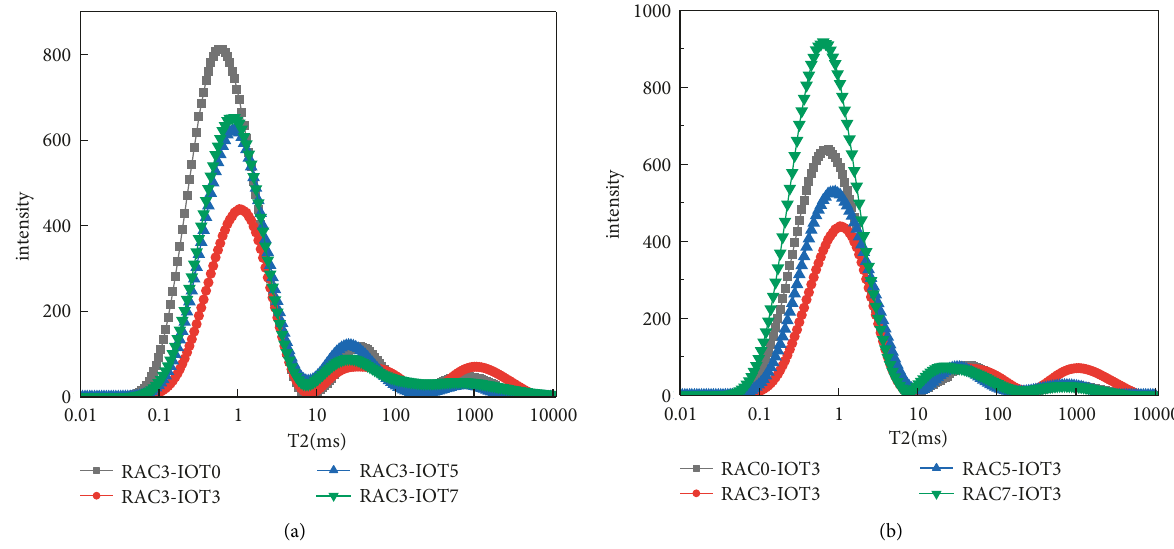
Figure 12: T2 Atlas before F-Tcycles with different mixing ratios: (a) the replacement rate of RCA is 30%; (b) the replacement rate of IOT is